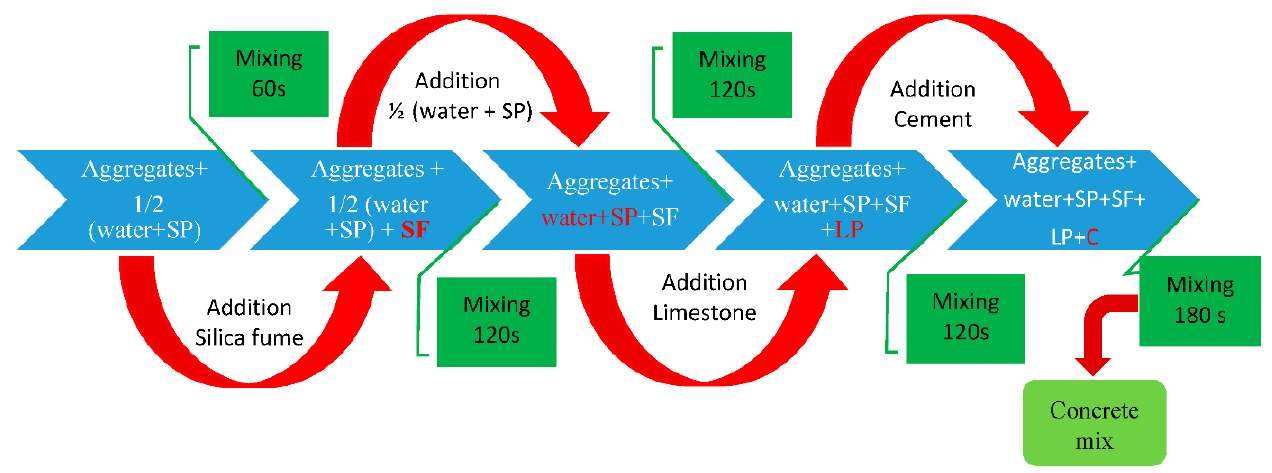
Figure 2. Mix procedure of concrete mixes.